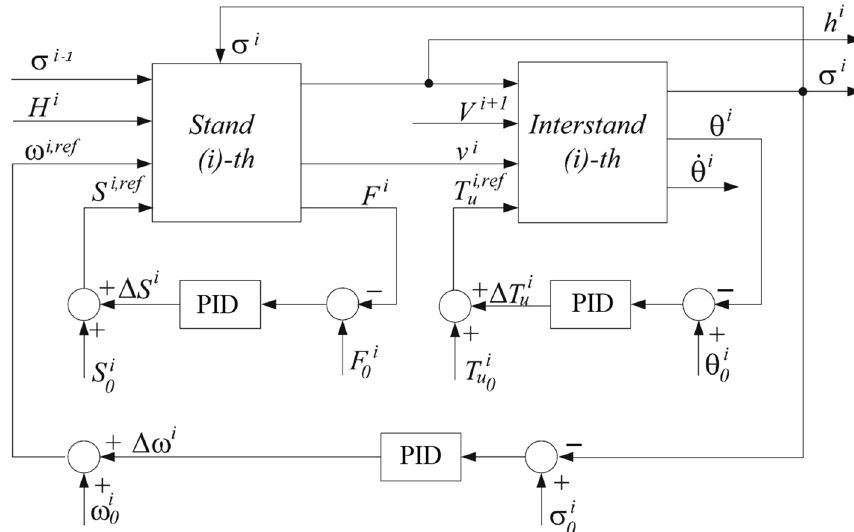
Fig. 6 Conventional PID control scheme (II)